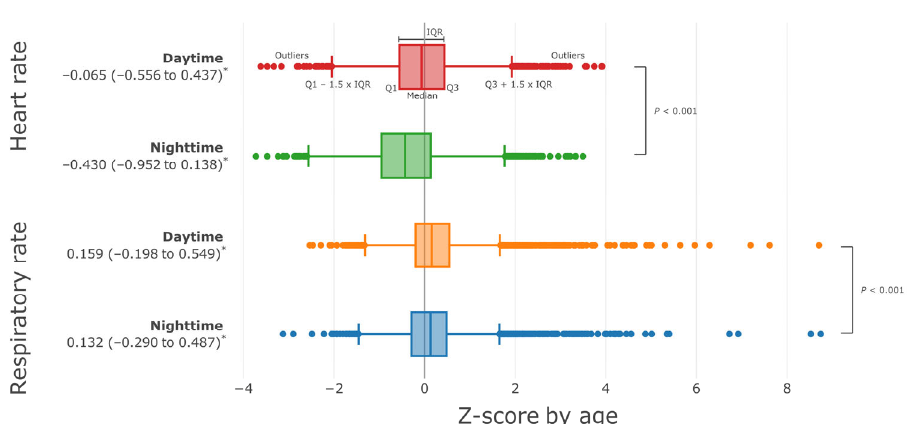
Figure 2. Distribution of z ‐ scores by age for heart rate and respiratory rate by time period. The z ‐ score by age was calculated based on the distribution of heart rate and respiratory rate derived from an existing nationwide study [19]. Daytime was defined as 8:00 to 20:00, and nighttime was defined as 20:00 to 8:00 the next day. Wilcoxon signed ‐ rank test was used for comparison by paired group. * Median (IQR), IQR = interquartile range, Q1 = 1st quartile, Q3 = 3rd quartile.